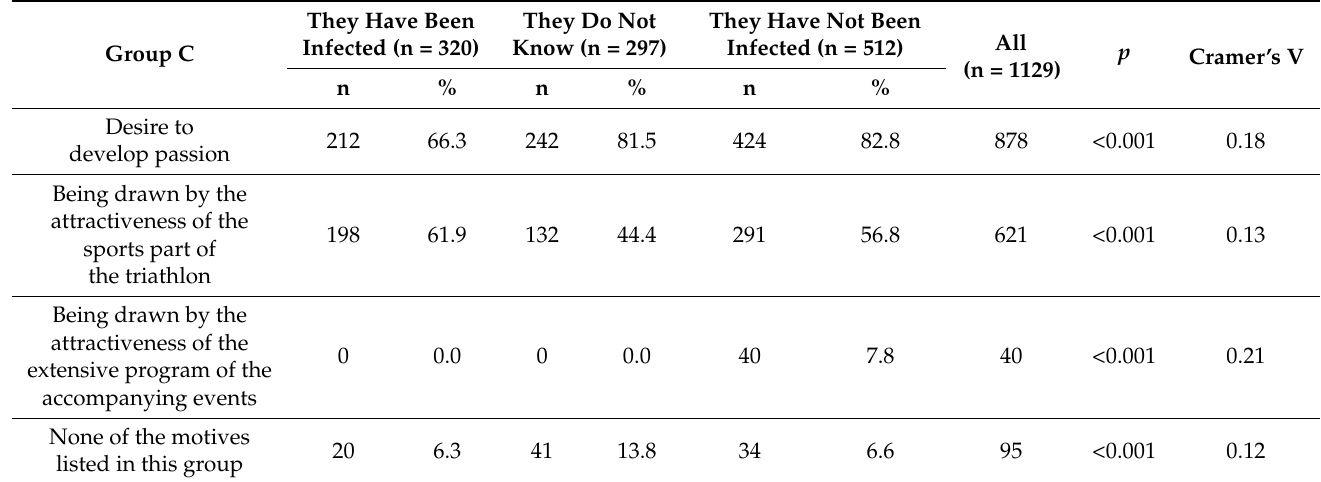
Table 4. Motives within the scope of factual orientation versus COVID-19 infection.